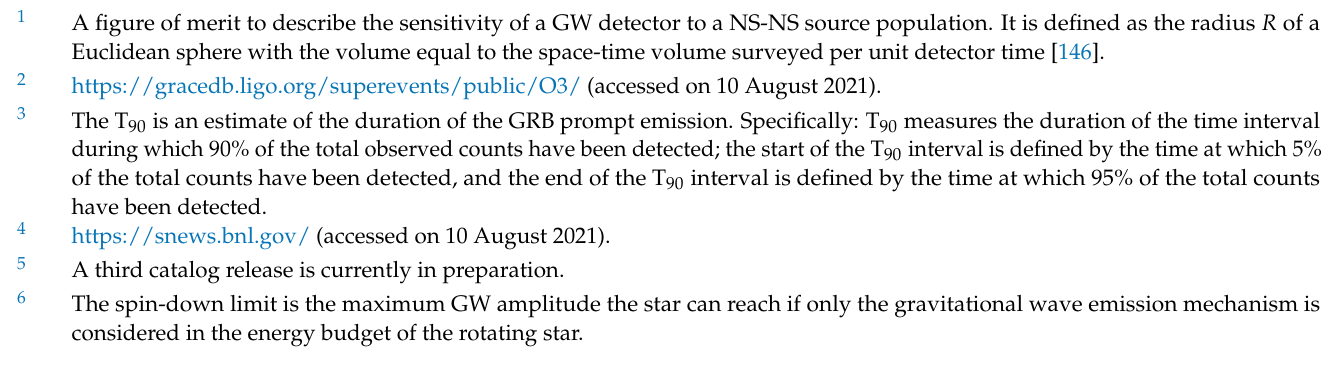
A figure of merit to describe the sensitivity of a GW detector to a NS-NS source population. It is defined as the radius R of a Euclidean sphere with the volume equal to the space-time volume surveyed per unit detector time [146]. The T 90 is an estimate of the duration of the GRB prompt emission. Specifically: T 90 measures the duration of the time interval during which 90% of the total observed counts have been detected; the start of the T 90 interval is defined by the time at which 5% of the total counts have been detected, and the end of the T 90 interval is defined by the time at which 95% of the total counts have been detected. 4 A third catalog release is currently in preparation. The spin-down limit is the maximum GW amplitude the star can reach if only the gravitational wave emission mechanism is considered in the energy budget of the rotating